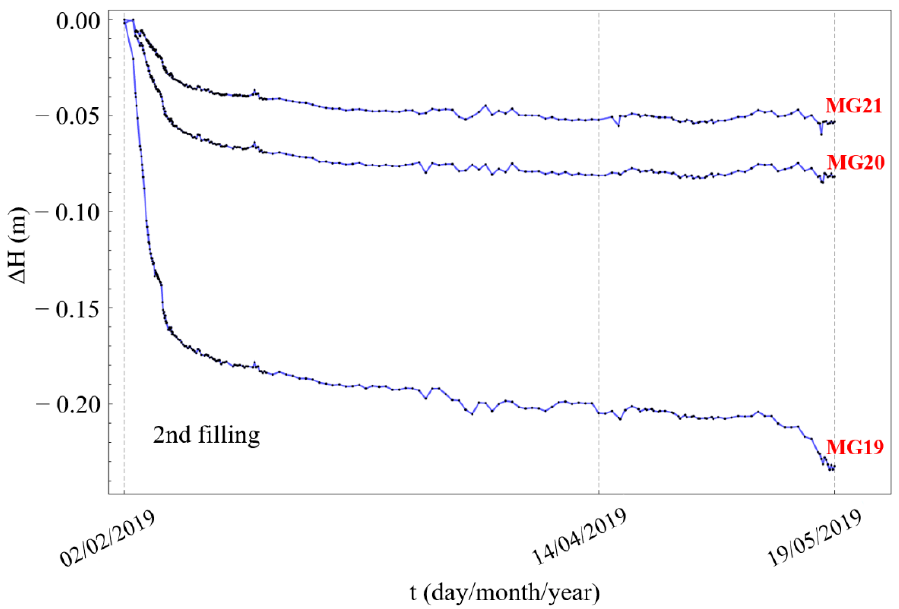
Figure 8. Settlement visualization of points MG19, MG20 and MG21, from 02 / 02 / 2019 to 19 / 05 / 2019.